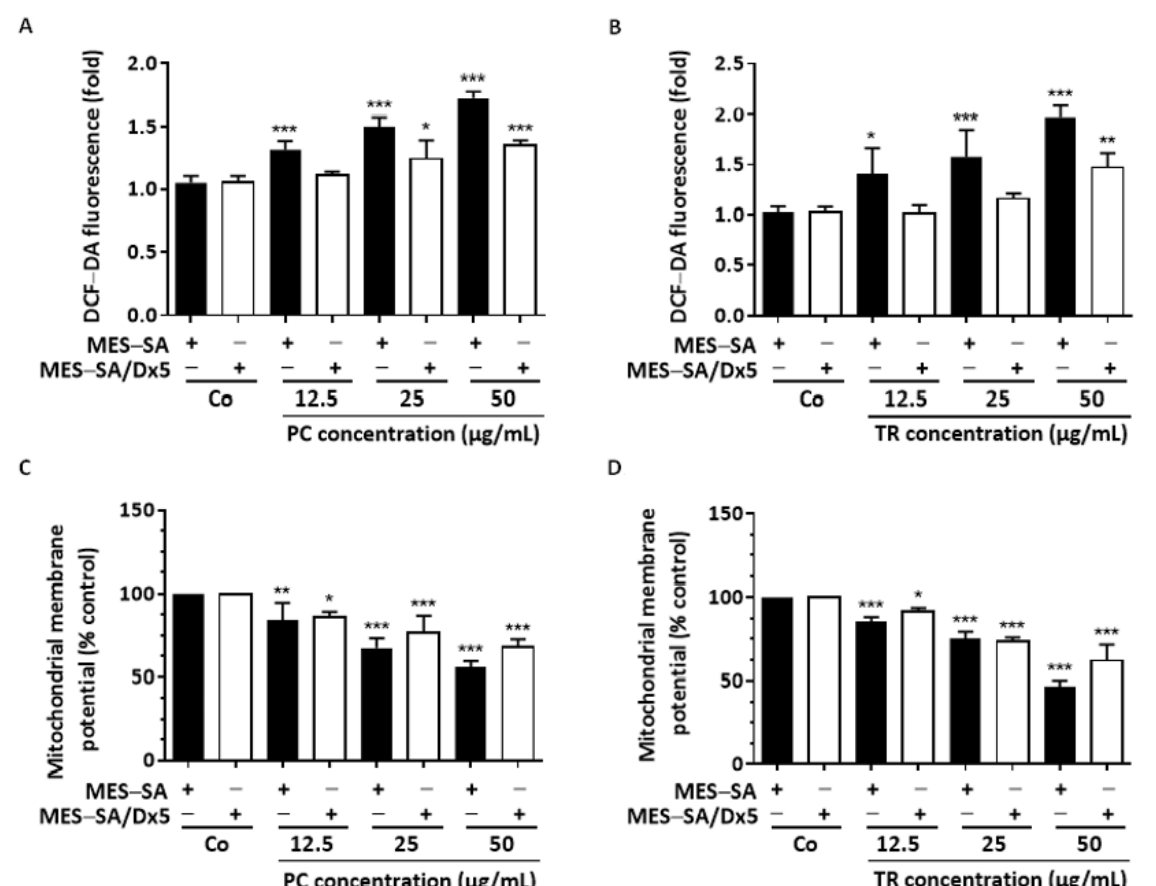
Figure 8. Pituranthos chloranthus (PC) and Teucrium ramosissimum Desf. (TR) extracts induce reactive oxygen species (ROS) accumulation and mitochondrial membrane potential ( ∆ Ψ m ) loss. ( A , B ) Both uterine sarcoma MES-SA and MES-SA/Dx5 cell lines were stained with DCFH after a 72 h treatment with vehicle (dimethyl sulfoxide, DMSO; Control, Co) or the indicated concentrations of PC ( A ) and TR ( B ). The fold changes of fluorescence intensity were relative to cells incubated with DCF with no drug treatment. ( C , D ) MES-SA and MES-SA/Dx5 cells were incubated for 72 h with medium containing vehicle (Co) or increasing concentrations of PC ( C ) and TR ( D ), followed by rhodamine 123 staining. Data are expressed as the mean ± Standard Deviation (SD) of three independent experiments; p -values were determined by a two-way ANOVA followed by Dunnett’s multiple comparison test. * p < 0.05, ** p < 0.01, and *** p < 0.001 compared to control (Co) conditions of each cell line.